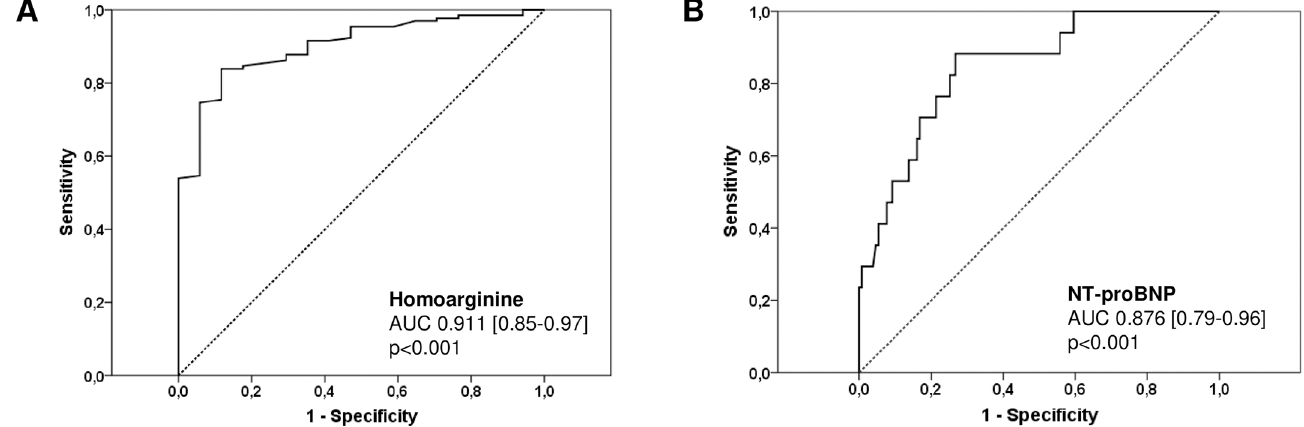
Fig 4. Receiver-operating characteristic (ROC) curves comparing sensitivity and specificity of hArg and NT-proBNP levels in predicting death due to progressive heart failure or occurrence of overt heart failure. AUC, area under the curve.